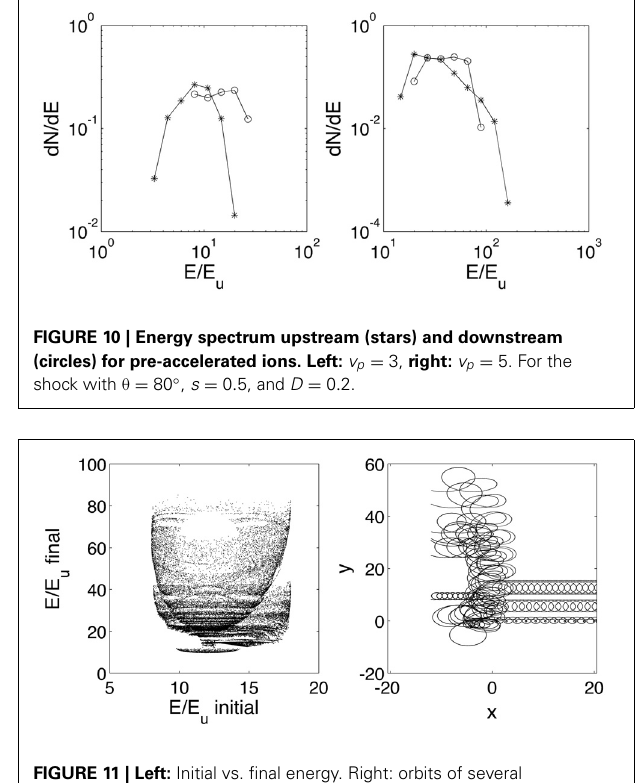
FIGURE 9 | Left: Trajectories of several pickup ions for D = 0 . 1. Right: for comparison trajectories for D = 0 . 2. Other shock parameters: θ = 70 ◦ and s = 0 . 5.